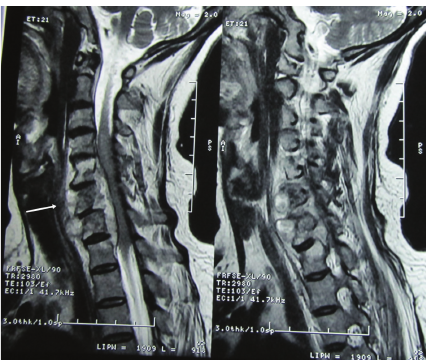
Figure2:MRIofcervicodorsalspineshowingalteredmarrowsignal intensity with erosion of C5 to D1 vertebrae and compression of spinal cord.